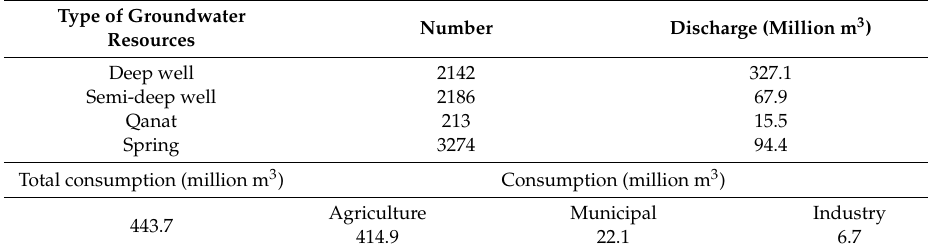
Table 1. The status of groundwater resources (wells, springs and qanats) and consumption (drinking, agriculture and industry) in the studied area. Data from Iran Water Resources Management Company,